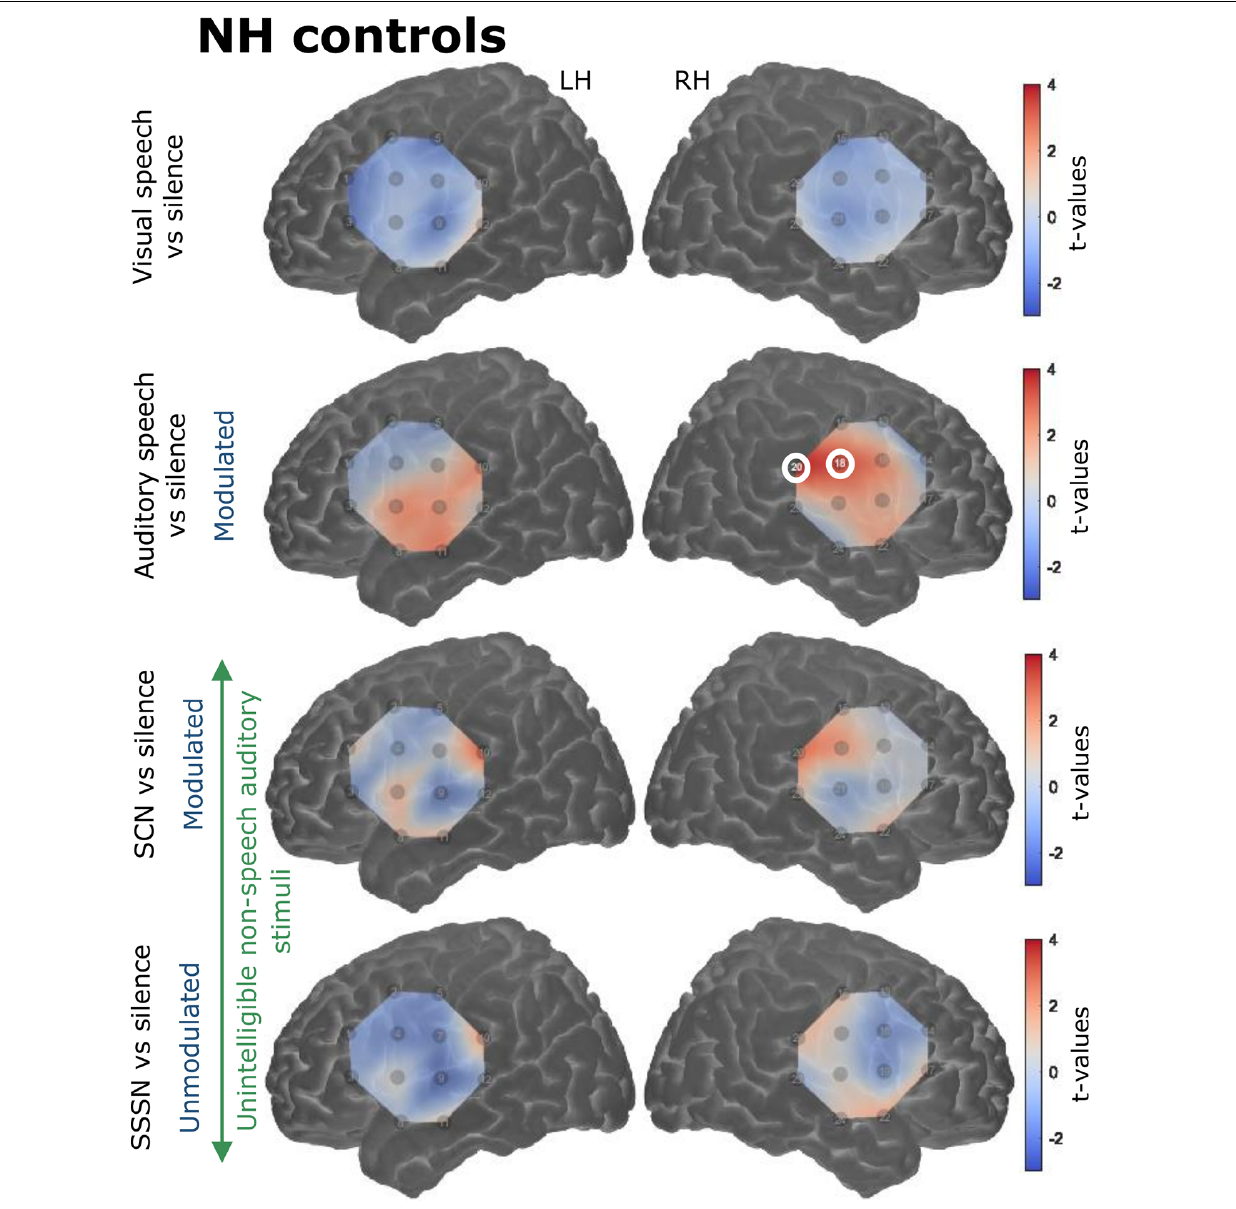
FIGURE 6 | Group level cortical activation maps for each stimulation condition contrasted against silence in normally-hearing (NH) controls in the LH and the RH. Channels circled in white show statistically significant activation [ q < 0.05, false discovery rate (FDR) corrected]. Only channels targeting temporal regions in the RH under the auditory speech condition were significantly activated. Note that the maps are interpolated from single-channel results and the overlay on the cortical surface is for illustrative purposes